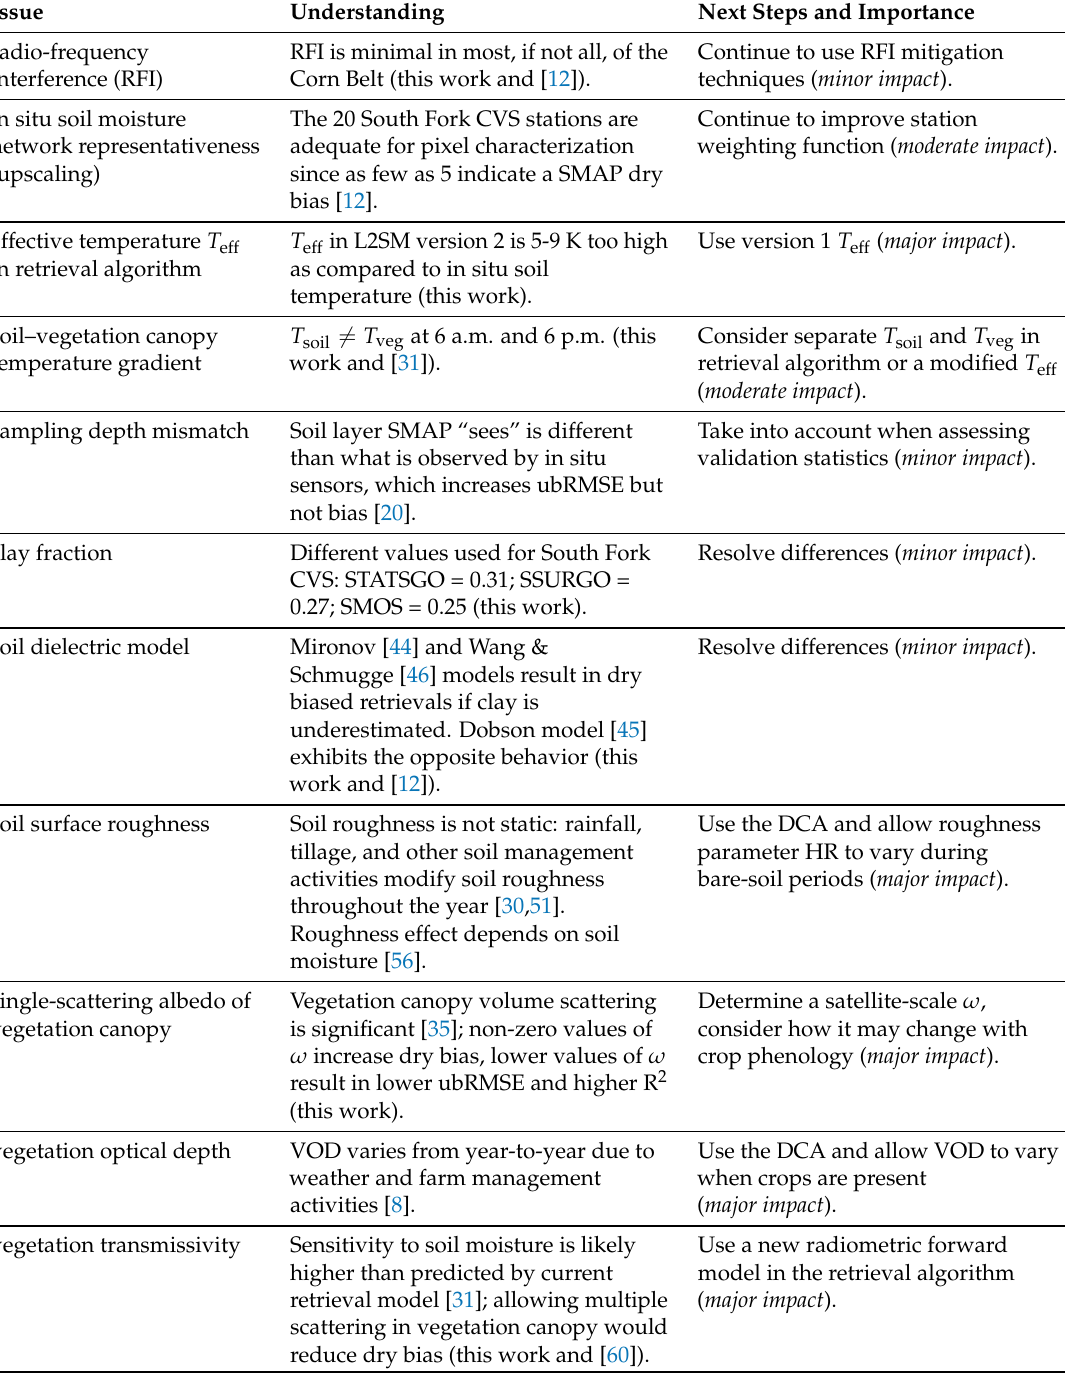
Table 6. Current understanding of SMAP soil moisture retrieval issues in the U.S. Corn